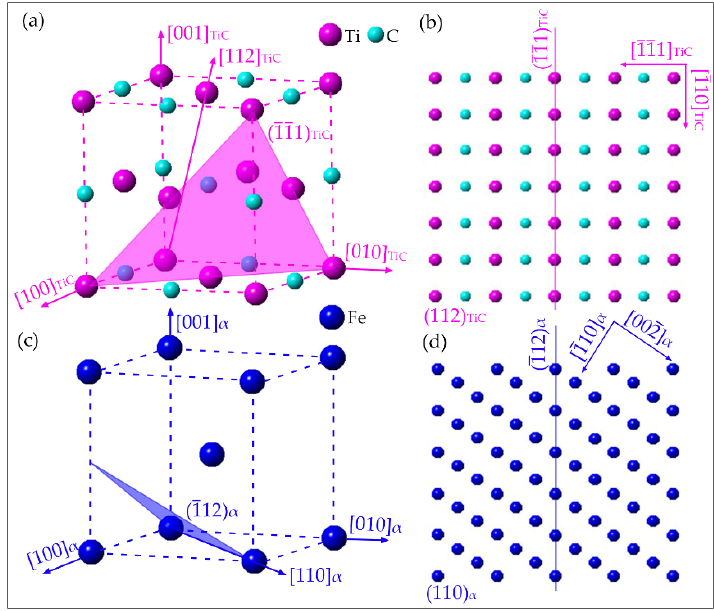
Figure 10. Simulation result of the new orientation relationship by Crystal Maker software. ( a ) unit cell of TiC with the indexing of plane ( c , d ) atom distribution of TiC and ferrite in the zone axis of [ 112 ]